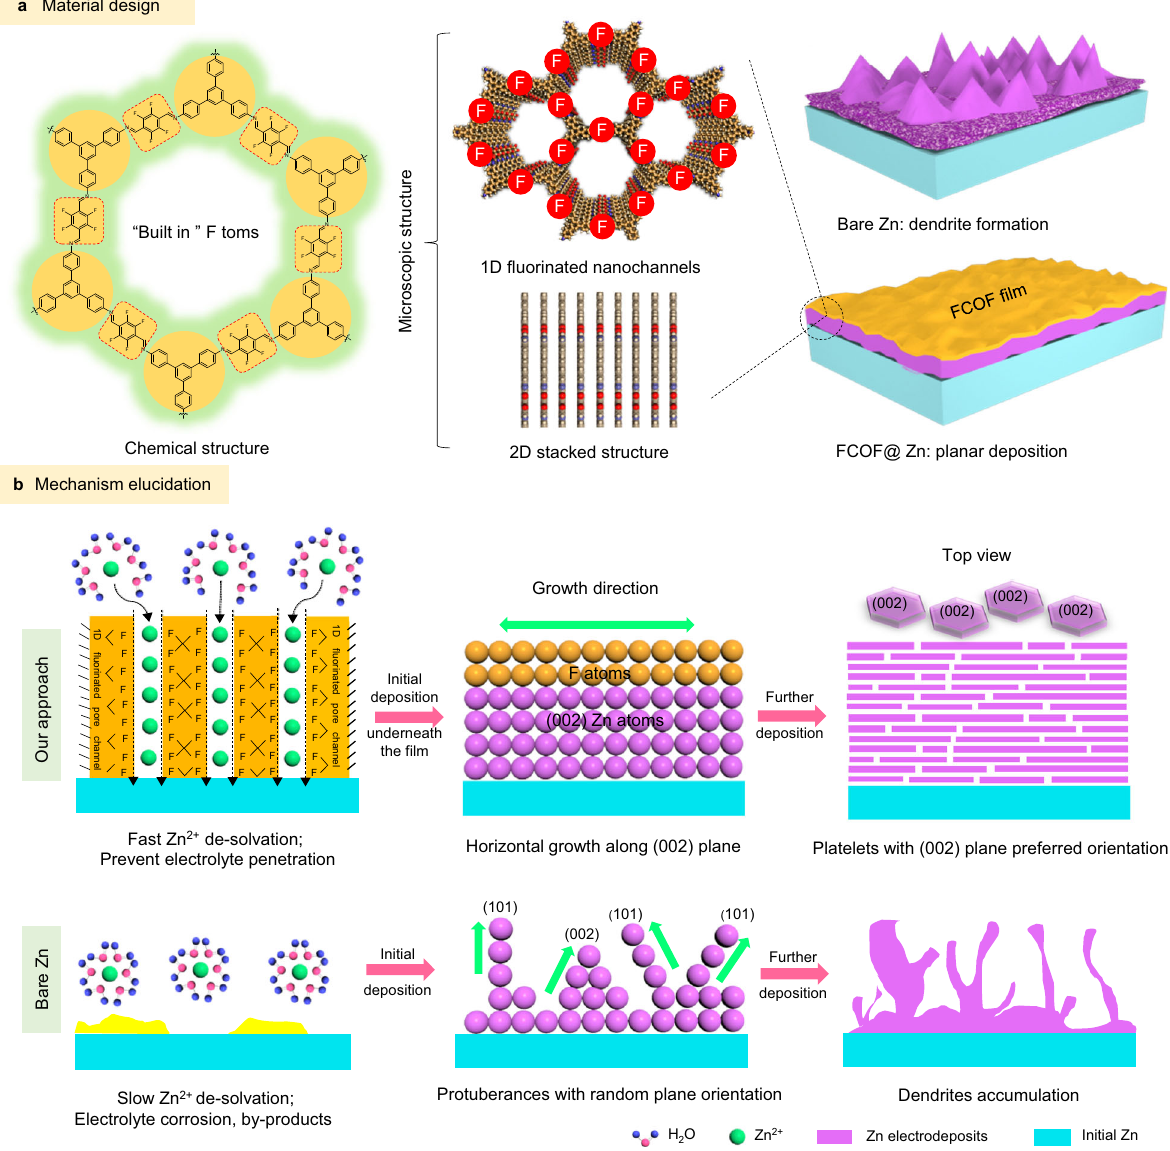
Fig. 1 The FCOF structure design and stabilizing mechanism elucidation. a The physicochemical structure of the FCOF fi lm, showing suppression of dendrites. b Mechanism comparison of the deposition processes for FCOF@Zn and bare Zn